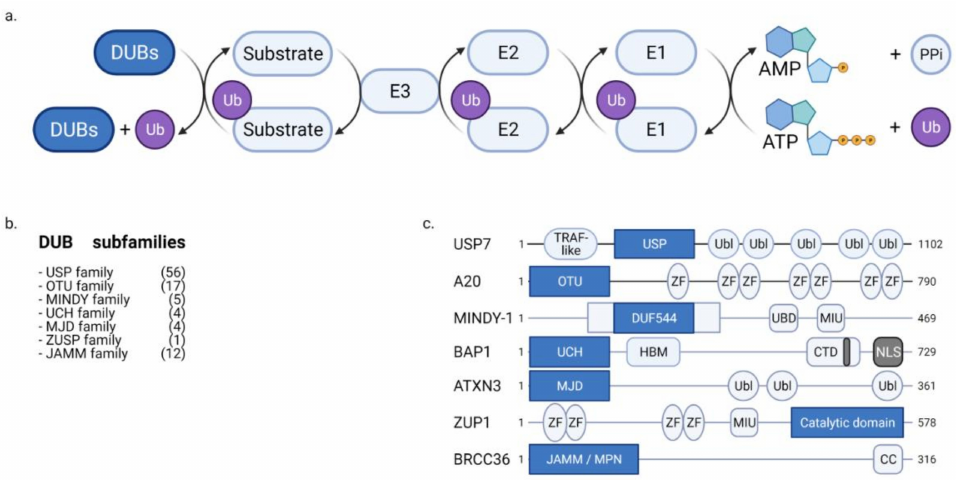
Figure 2. Ubiquitination/deubiquitination cascades and families of deubiquitinases (DUBs). ( a ) DUBs cleave ubiquitin conjugated to the substrates. The modulation of ubiquitination status protects the substrates from proteasomal or lysosomal degradation and regulates the signaling capacities of the substrates. ( b , c ) DUBs are grouped into USP, OTU, JAMM, MINDY, UCH, MJD, and ZUSP families depending on the characteristic of the conserved